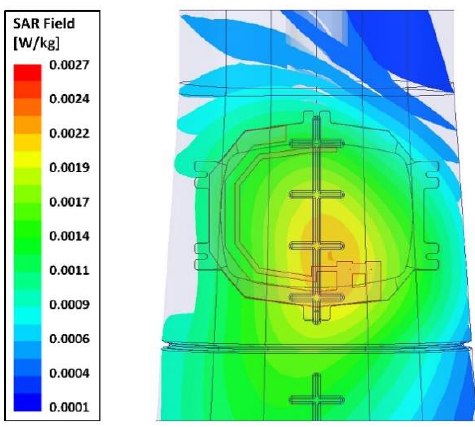
Figure 9. Simulated specific absorption rate (SAR) distribution on a Speag phantom arm [62] at 868 MHz.